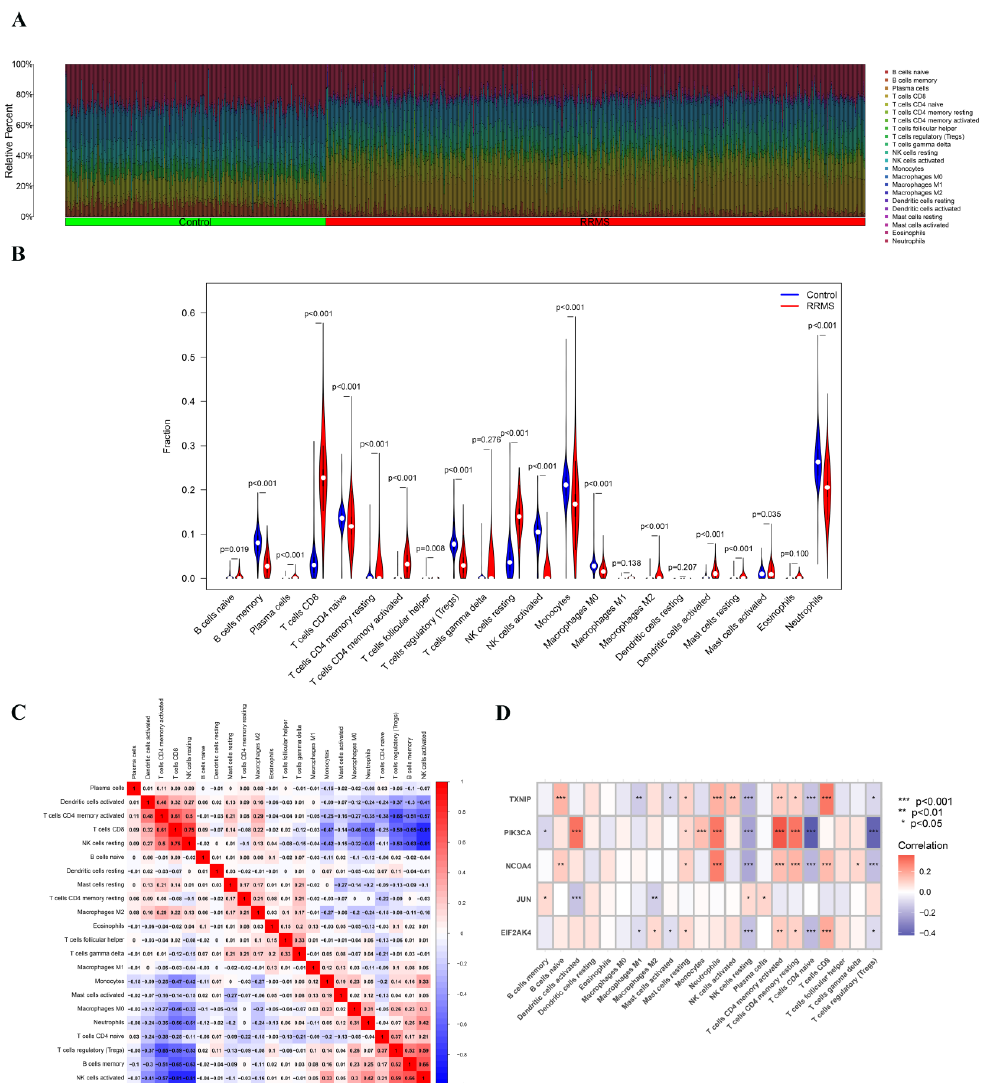
Figure 7. Immune cell infiltration analysis. ( A ) Relative proportions of 22 immune cells between RRMS and healthy control groups. ( B ) Violin plot showing differences in 22 types of immune cells’ infiltration between RRMS and healthy control groups. ( C ) Correlation heatmap of immune cell infiltration between RRMS and healthy control groups. The number in the box represents the correlation coefficient, red represents a positive correlation and blue represents a negative correlation. ( D ) Correlation analysis between 22 types of immune cells and 5 hub FRGs identified by the SVM model. Red represents a positive correlation, and blue represents a negative correlation. * p < 0.05, ** p < 0.01, *** p < 0.001.